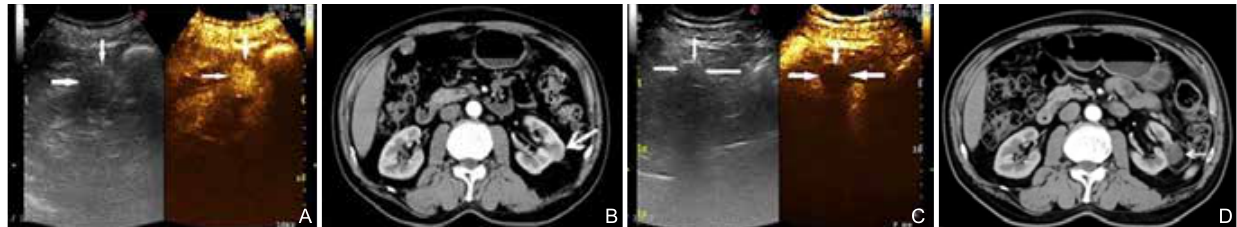
A B C Figure 3 Imaging changes before and after RFA of renal tumors (complete ablation) (A) Contrast-enhanced ultrasound images before RFA: rapid enhancement is visible in the tumor in the middle of the left kidney 15 s after injection of contrast media, and the intensity is higher than that in the peripheral renal parenchyma (arrows). (B) Contrast-enhanced CT images before RFA: the arterial phase shows early enhancement of the left renal lesion (arrows) with visible enhancement of the capsule at the margin of the lesion. (C) Contrast-enhanced ultrasound images after RFA: no radio contrast agents are visible in the RFA zone, i.e. absence of contrast filling. (D) Contrast-enhanced CT images after RFA: the arterial phase shows that the enhanced lesion on preoperative examination became a low-intensity lesion without enhancement. RFA, radiofrequency ablation. (Reprinted with permission from reference [28])